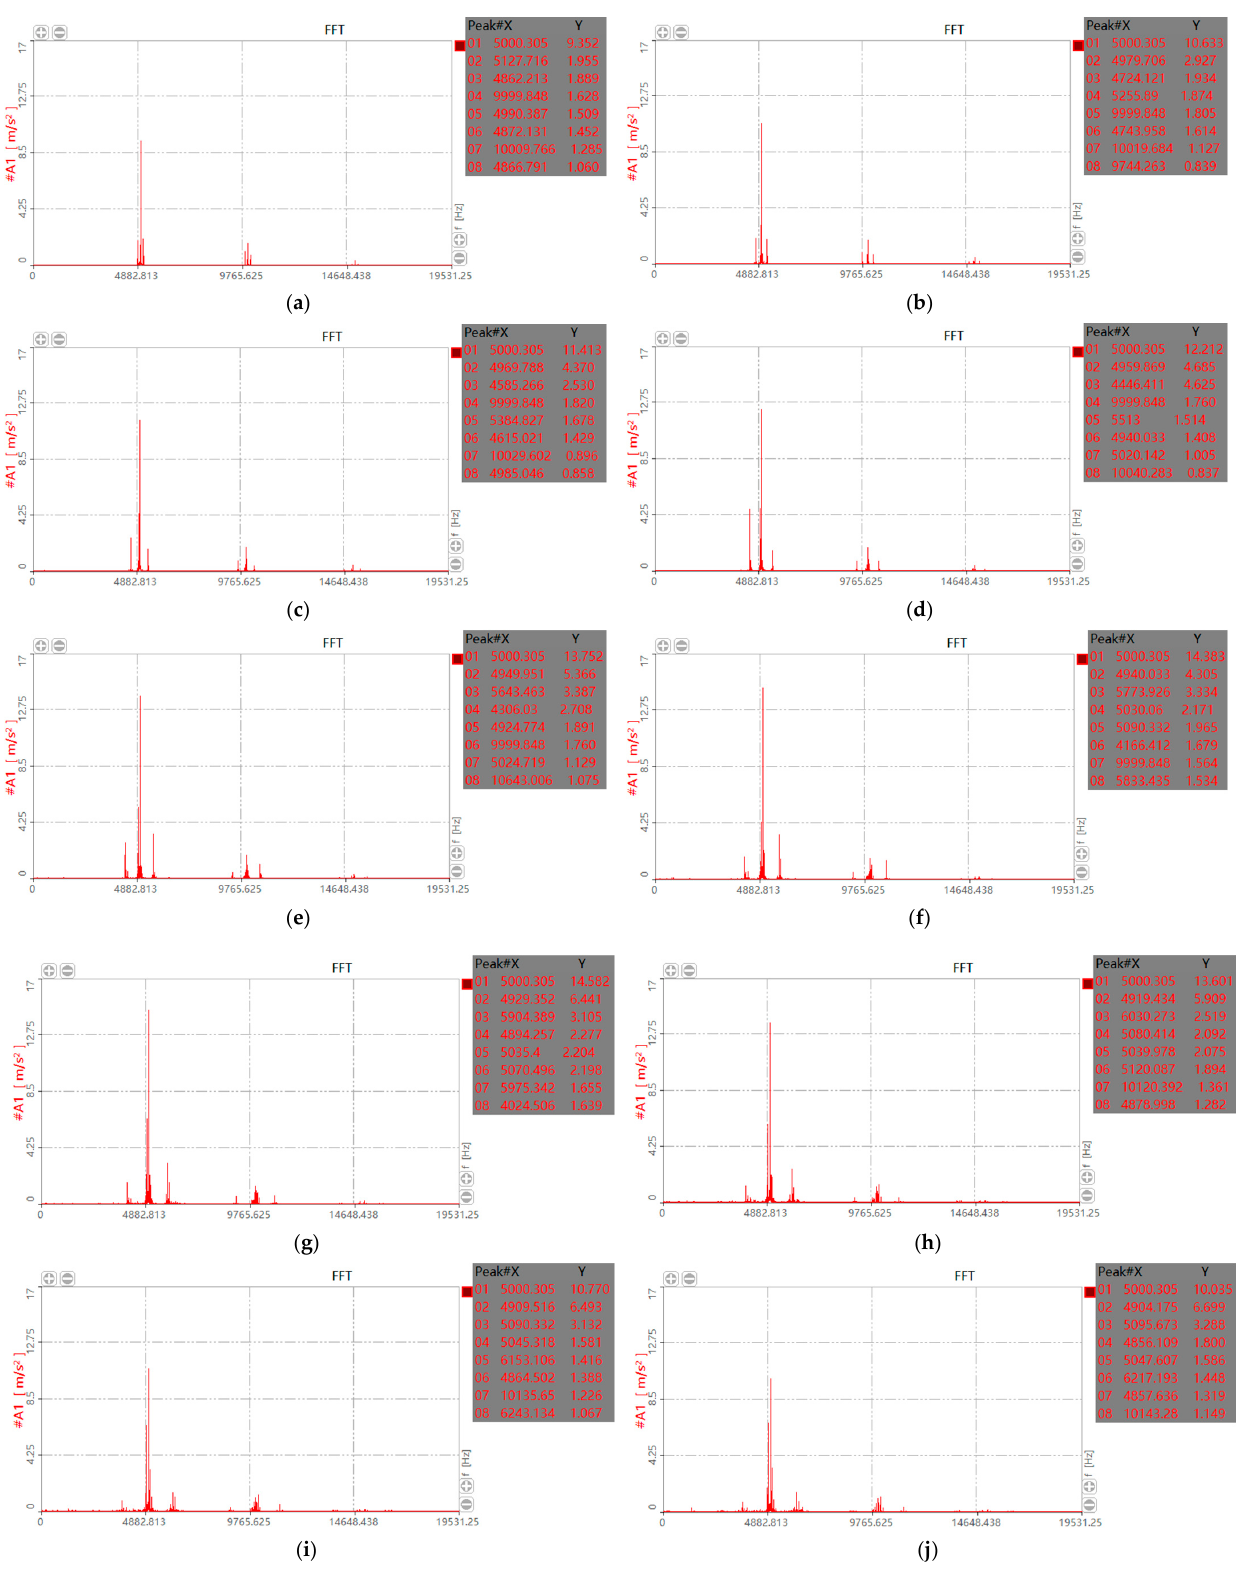
Figure 7. The vibration acceleration spectrum of the top point #A1 in 10 stages. ( a ) Stage 1, f = 0.1 f 1 ; ( b ) Stage 2, f = 0.2 f 1 ; ( c ) Stage 3, f = 0.3 f 1 ; ( d ) Stage 4, f = 0.4 f 1 ; ( e ) Stage 5, f = 0.5 f 1 ; ( f ) Stage 6, f = 0.6 f 1 ; ( g ) Stage 7, f = 0.7 f 1 ; ( h ) Stage 8, f = 0.8 f 1 ; ( i ) Stage 9, f = 0.9 f 1 ; ( j ) Stage 10, f = f 1